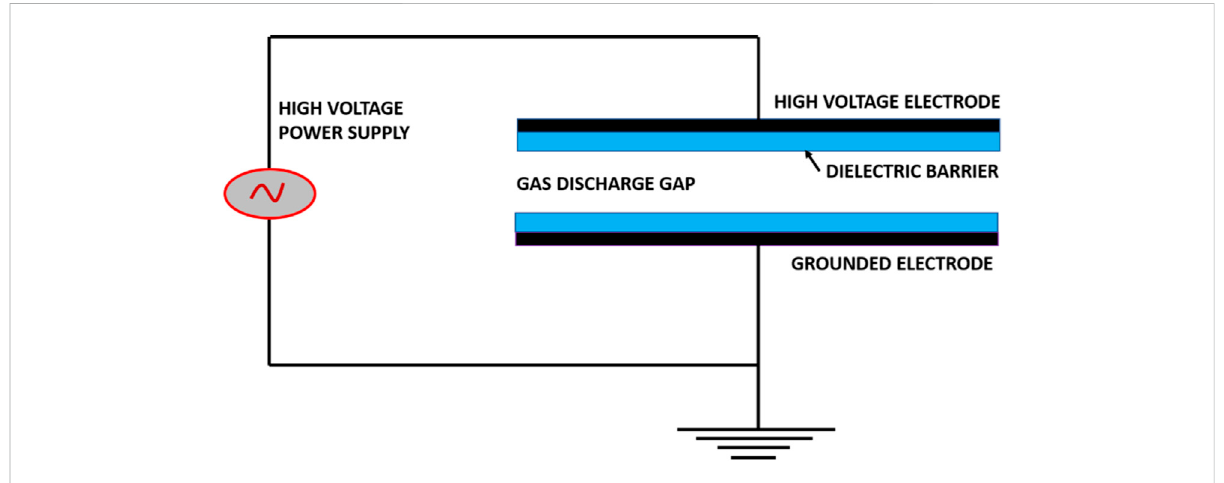
FIGURE 2 Schematic of dielectric barrier discharge — DBD.